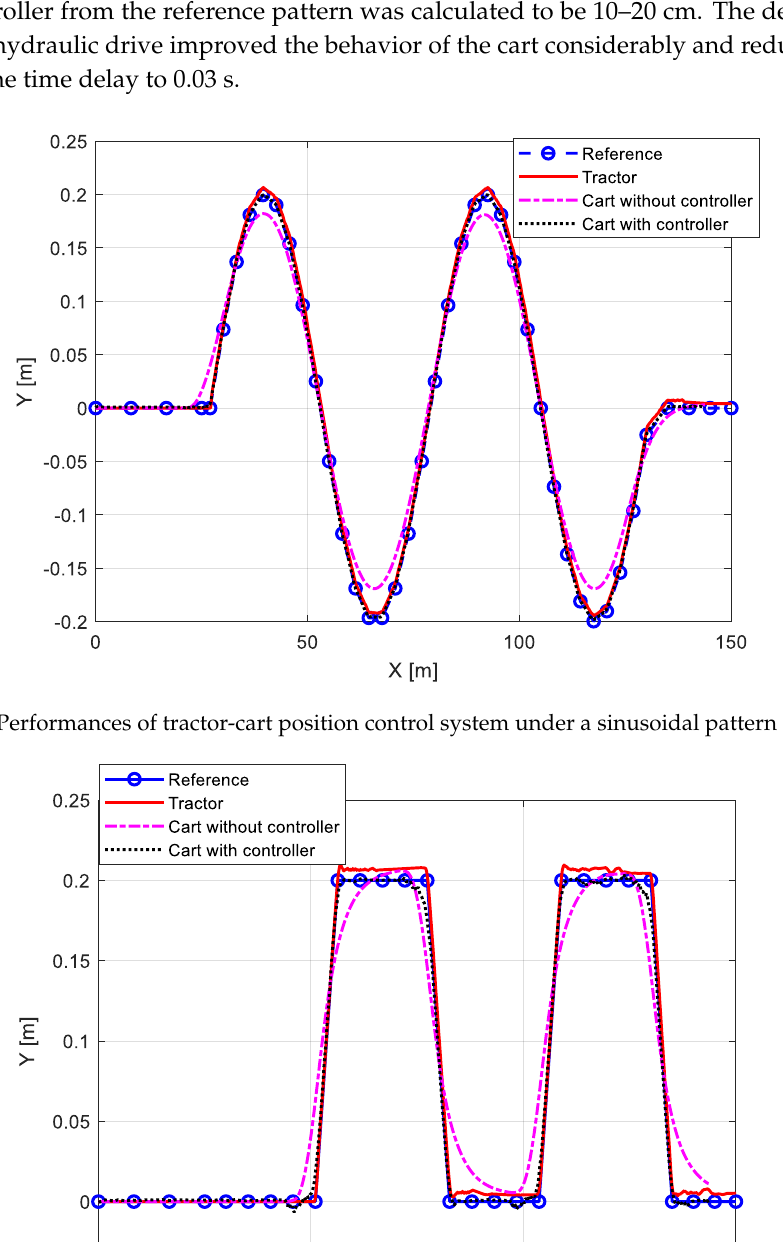
Figure 12. Performance of tractor-cart position control system under a Pulse pattern at 3 [m/s] .